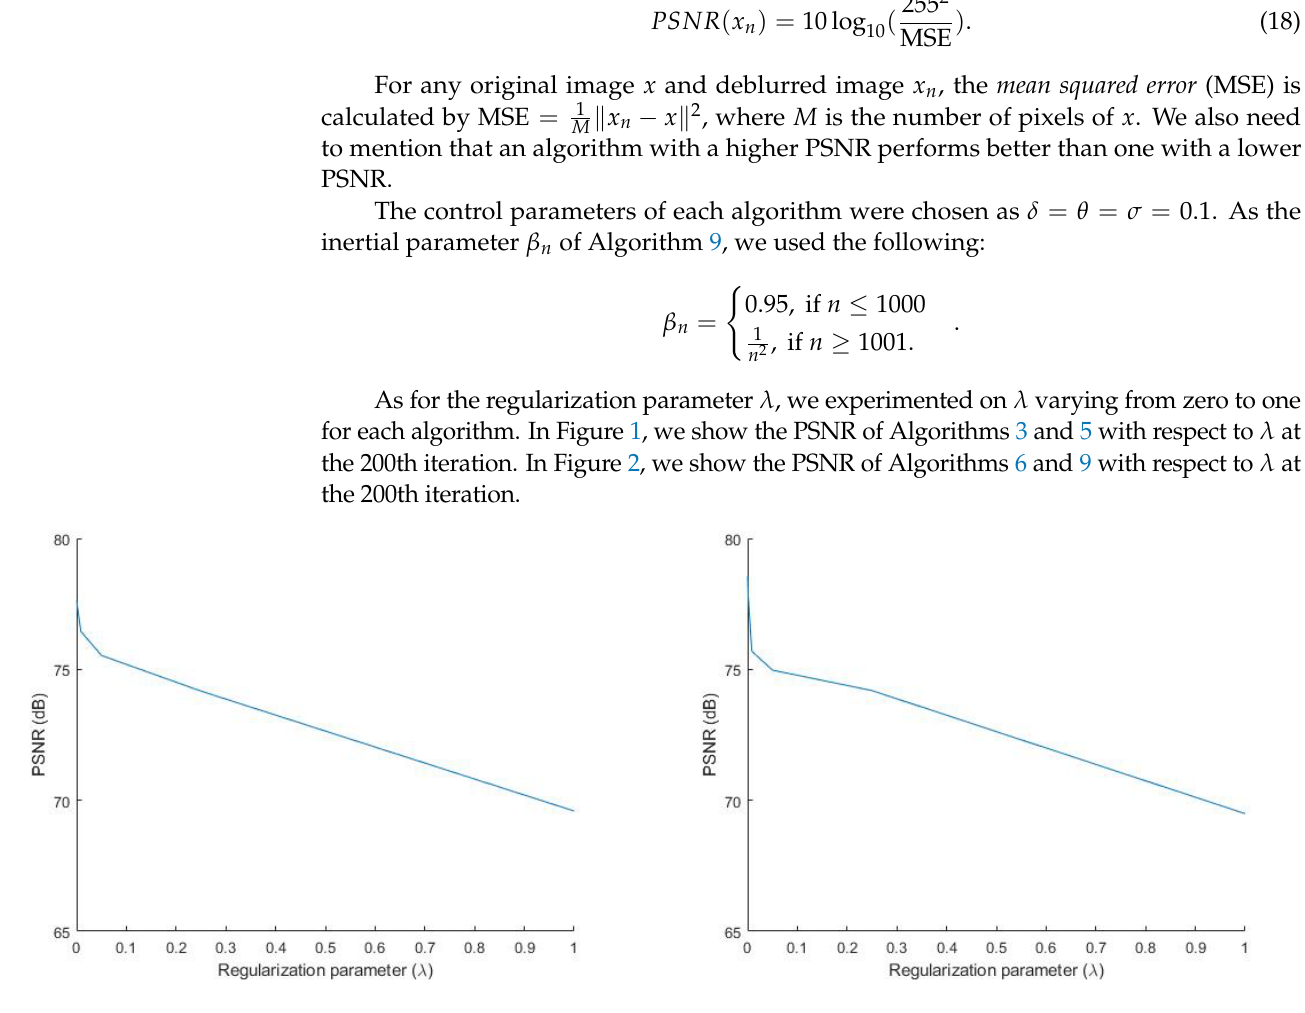
Figure 1. PSNR of Algorithm 3 (left) and Algorithm 5 (right) with respect to λ at the 200th iteration.